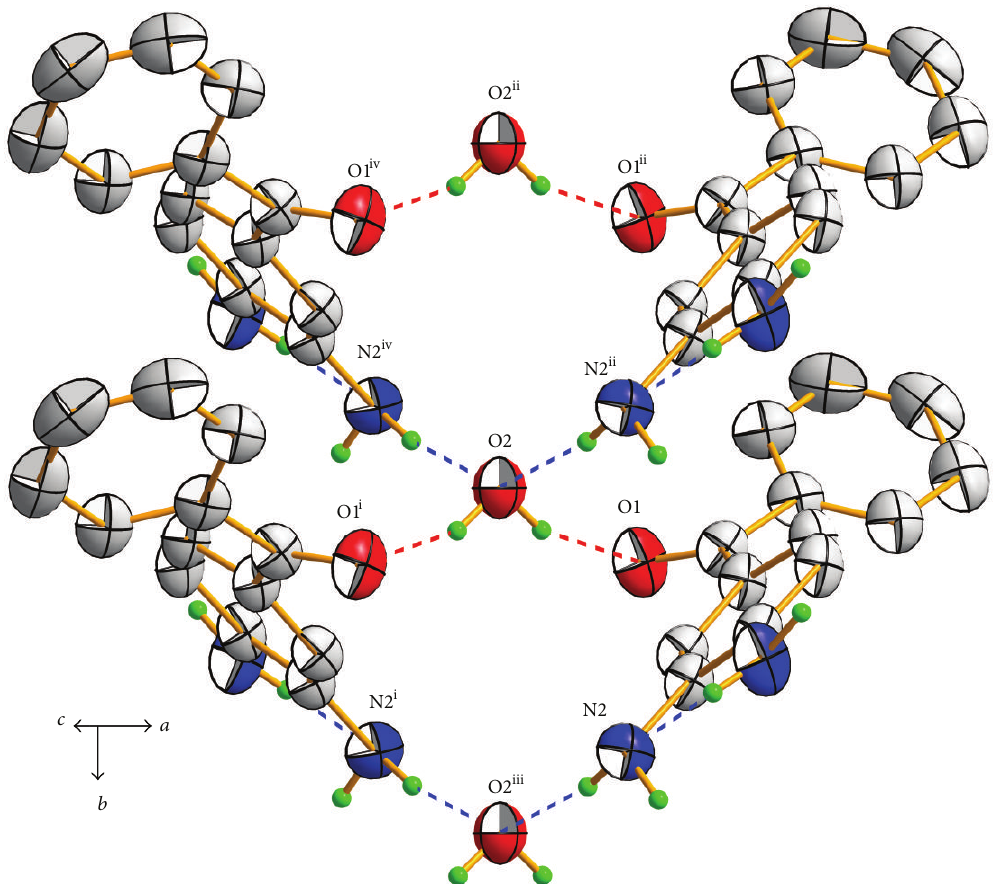
Figure 3: The role of water in the packing stabilization. H atoms not involved in hydrogen bonding (dashed lines) have been omitted for clarity. Displacement ellipsoids are drawn at 50% probability level. Symmetry codes: (i) − x , y , − z ; (ii) x , y − 1, z ; (iii) x , y + 1, z ; (iv) − x , y − 1, − z .